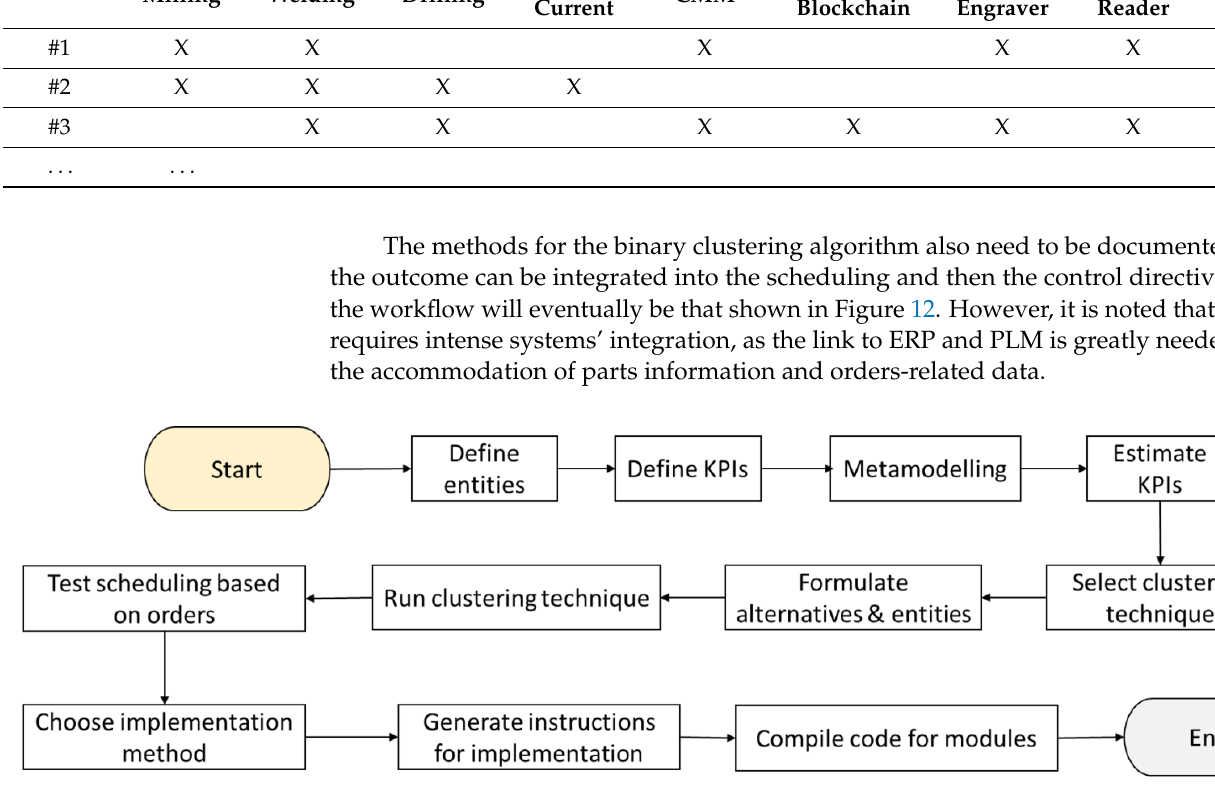
Figure 12. Workflow for process chain management.